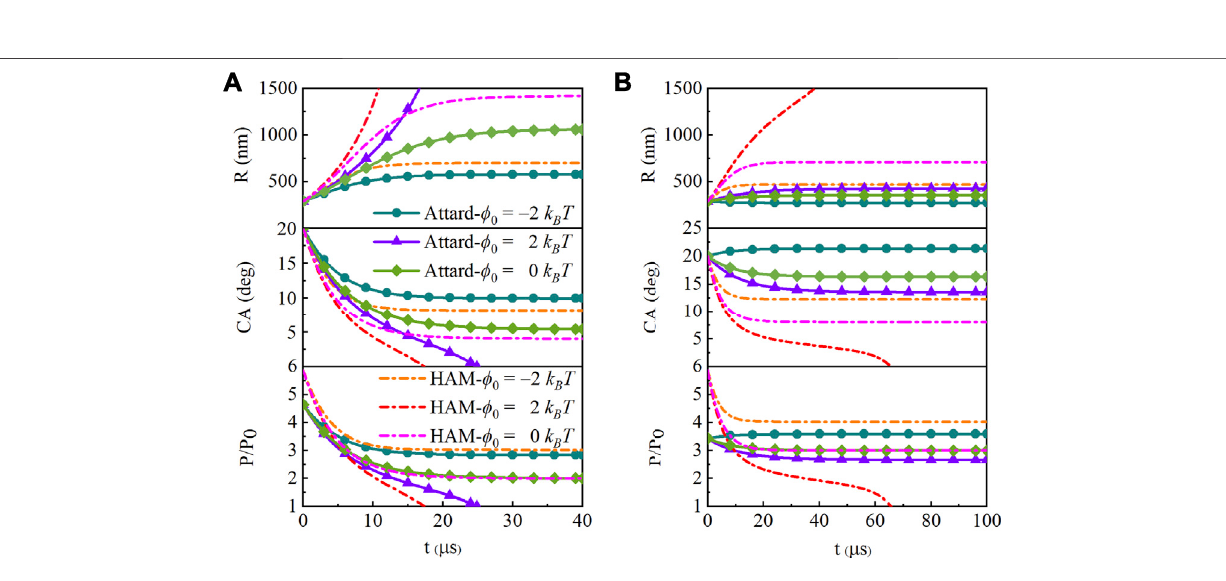
Frontiers in Physics |